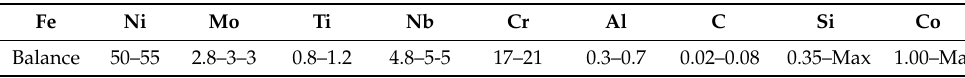
Figure 4. SEM images of the Inconel 718 powder after sieving. The nominal chemical composition (wt.%) of the commercial Inconel 718 is shown in Table 1. Table 1. Nominal chemical composition of commercial